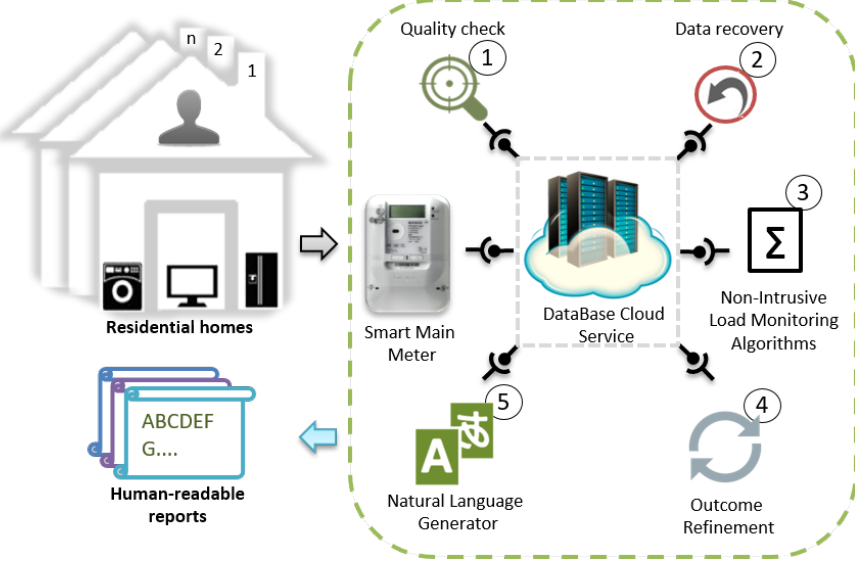
Figure 1. Conceptual view of the proposed